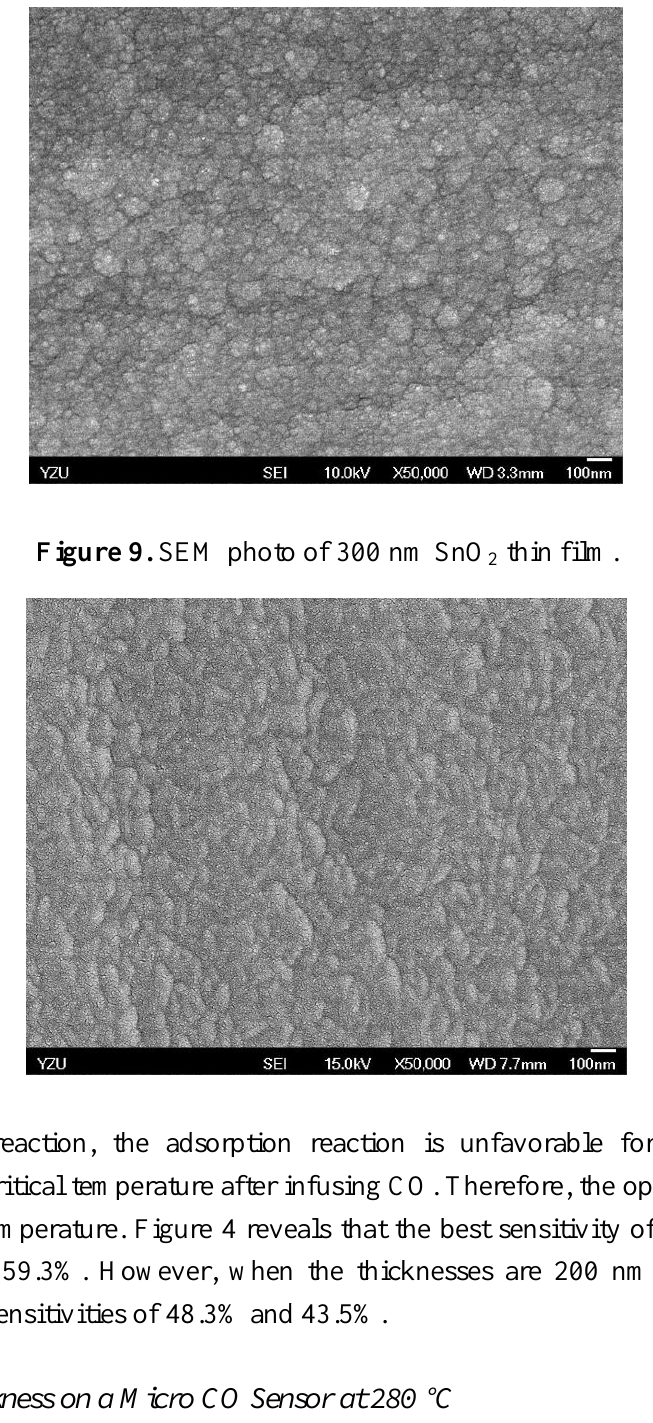
Figure 8. SEM photo of 200 nm SnO